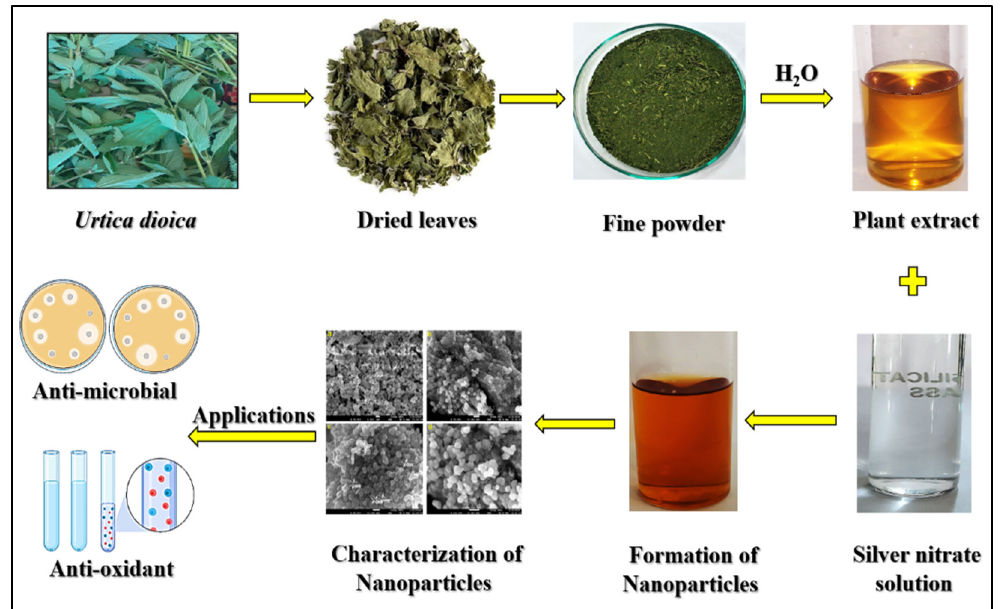
Figure 11. Graphical representation and applications of green synthesized silver nanoparticles through Urtica dioica .